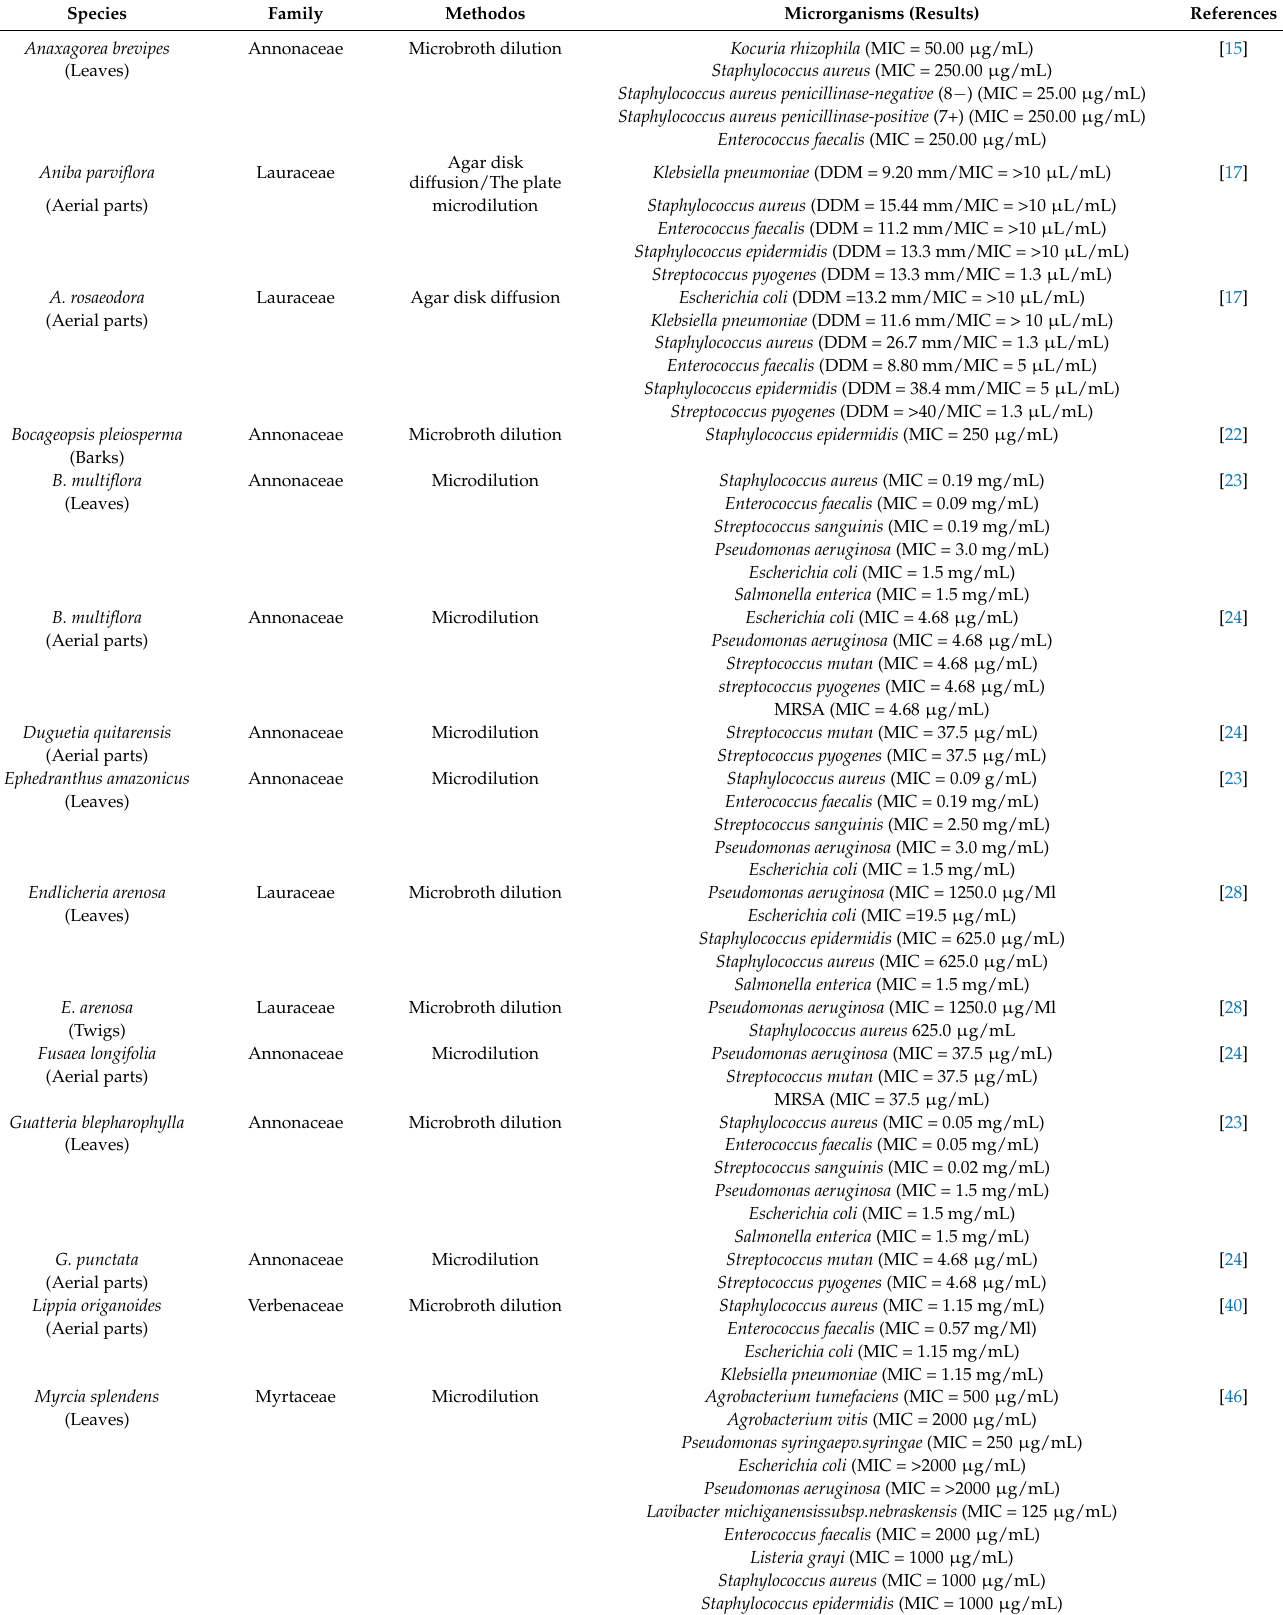
Table 3. Antibacterial activity of essential oils from species found in the